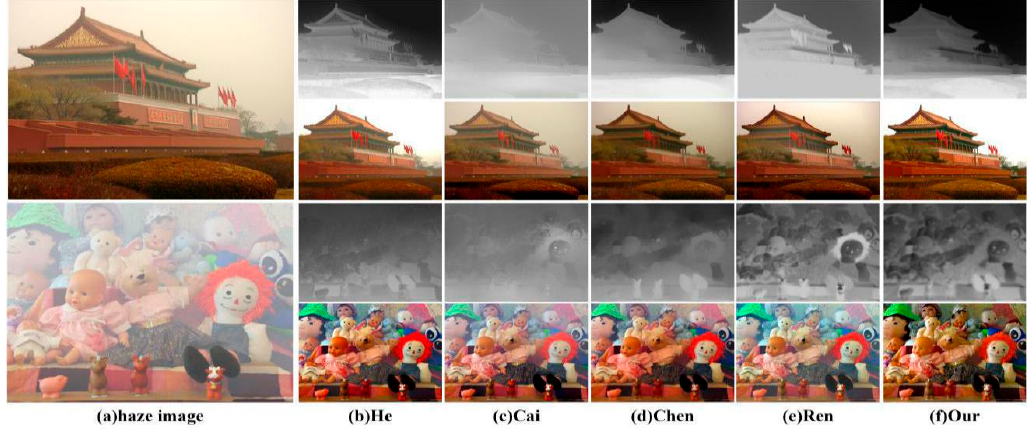
Figure 10. A comparison of the transmission.